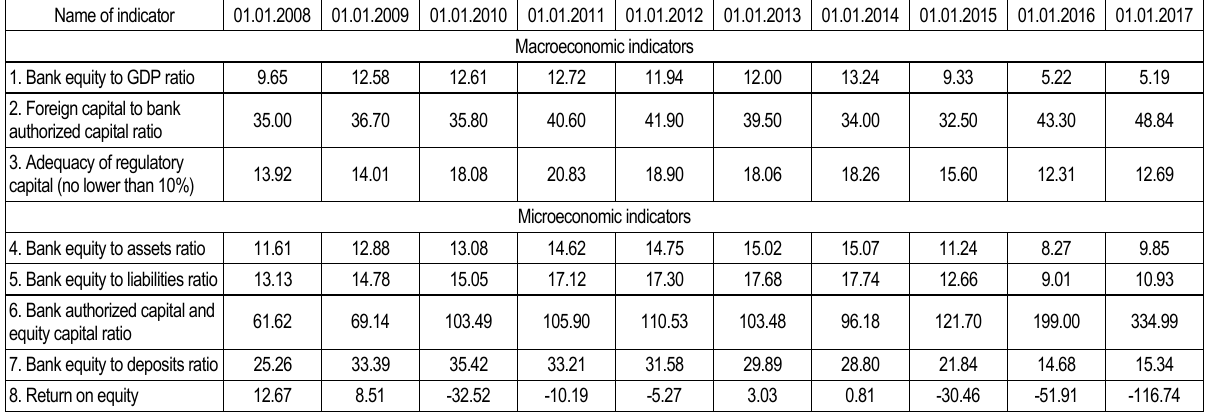
Table 1. Macro- and microeconomic indicators of the capital adequacy of the banking system of Ukraine in 2007–2016 * ,